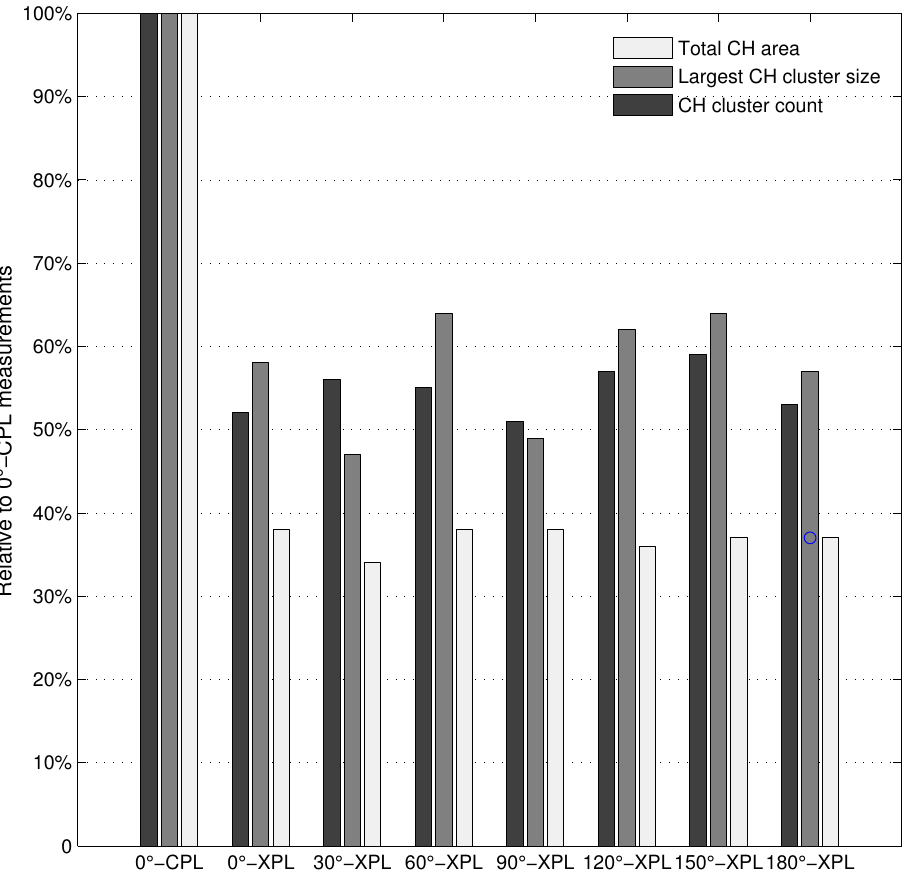
Figure 6. Comparison of selected portlandite metrics on the XPL images acquired at different rotary microscope stage positions relative to the measurements on the CPL